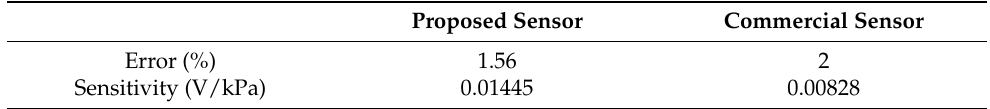
Table 8. Comparison of the observed error and sensitivity for the proposed sensor and the commer- cially available